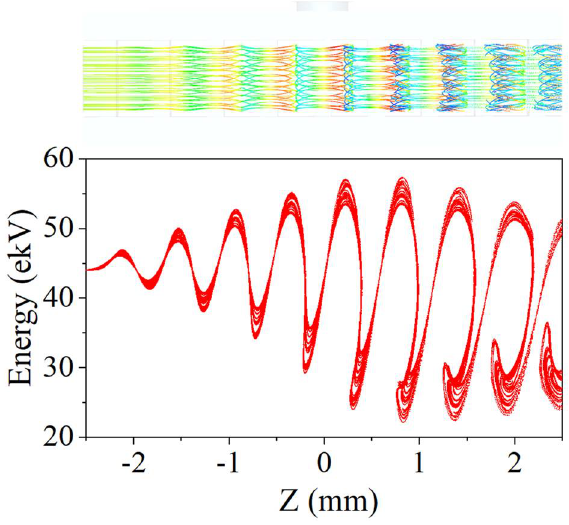
Figure 6. The trajectory of electrons on the Z-Y cross-section and the phase space plots of electrons.